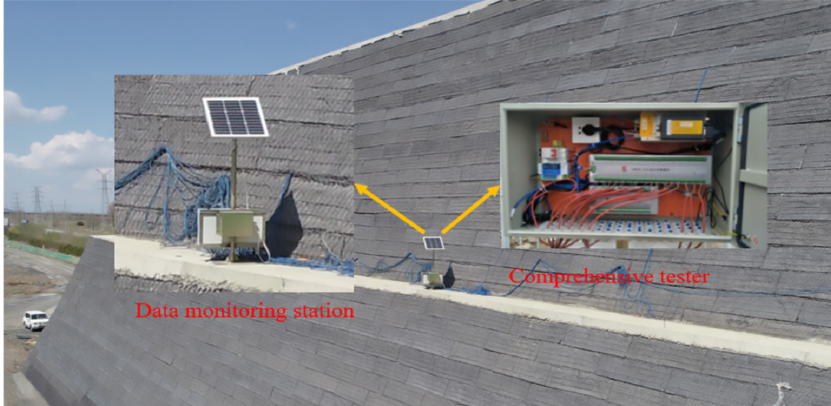
Figure 3. Comprehensive tester.